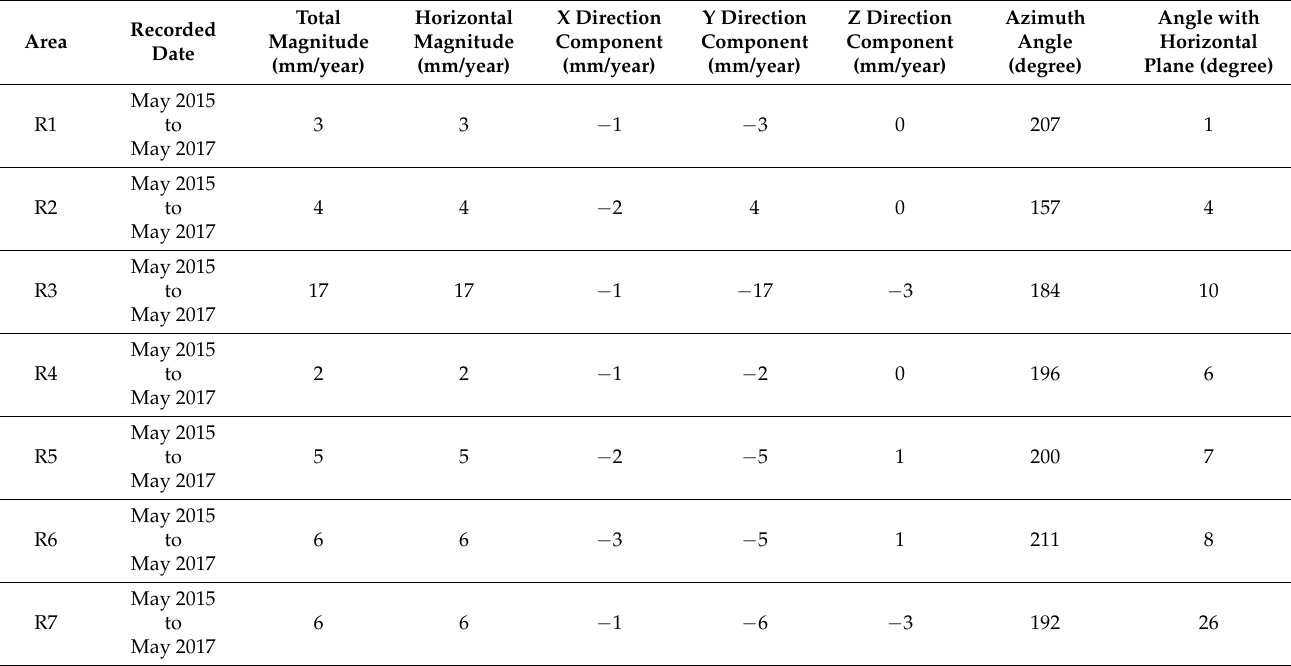
Figure 15. Calculated vertical component of R for selected sectors on the South landslide. Table 5. Summary of calculated R magnitude and geometry for the South landslide.